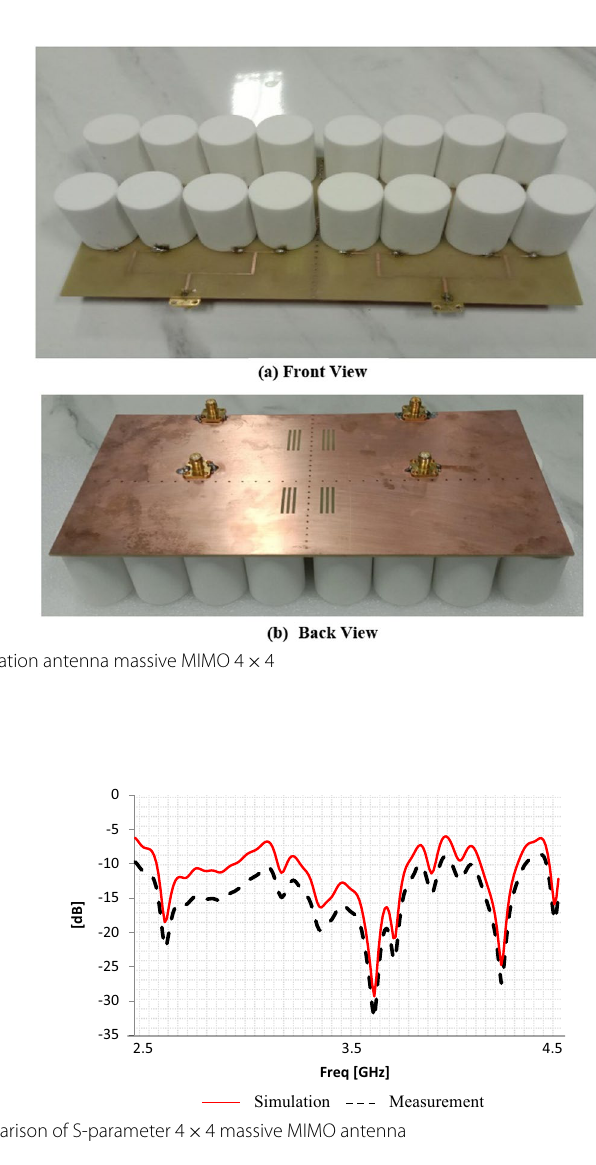
4 massive MIMO antenna ×